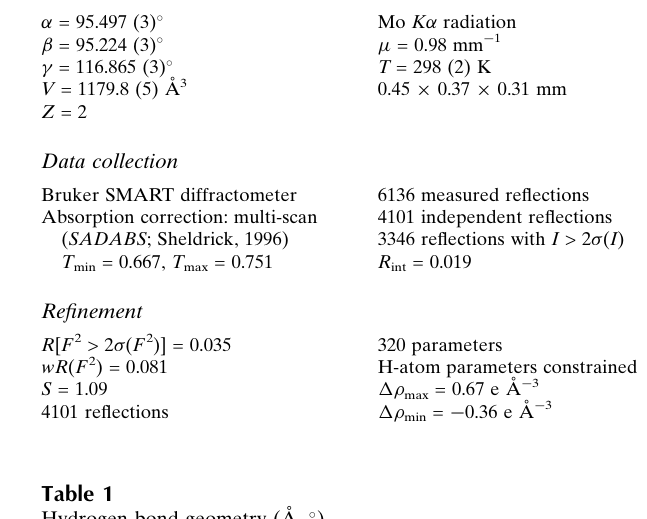
Hydrogen-bond geometry (A˚ , (cid:2)